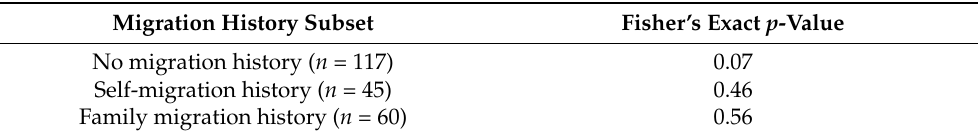
Table A2. Estimated p-values according to Fischer’s Exact Tests for the bivariate association between depression risk and gardening behavior stratified by migration